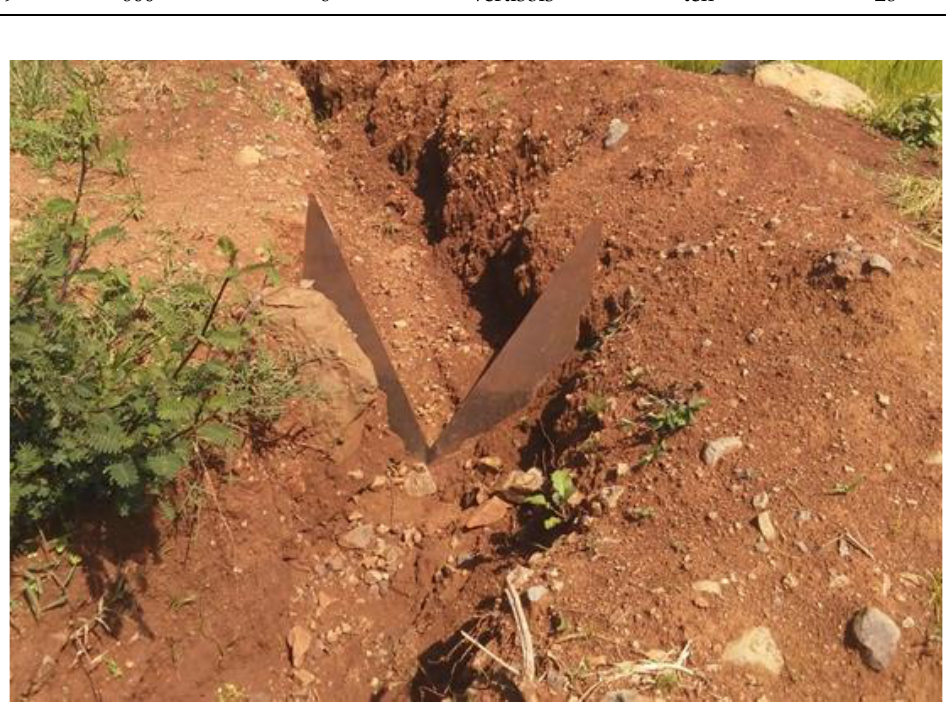
Figure 2. A typical triangular V-notch weir installed on the infiltration furrows at upslope positions of the Debre Mawi watershed.